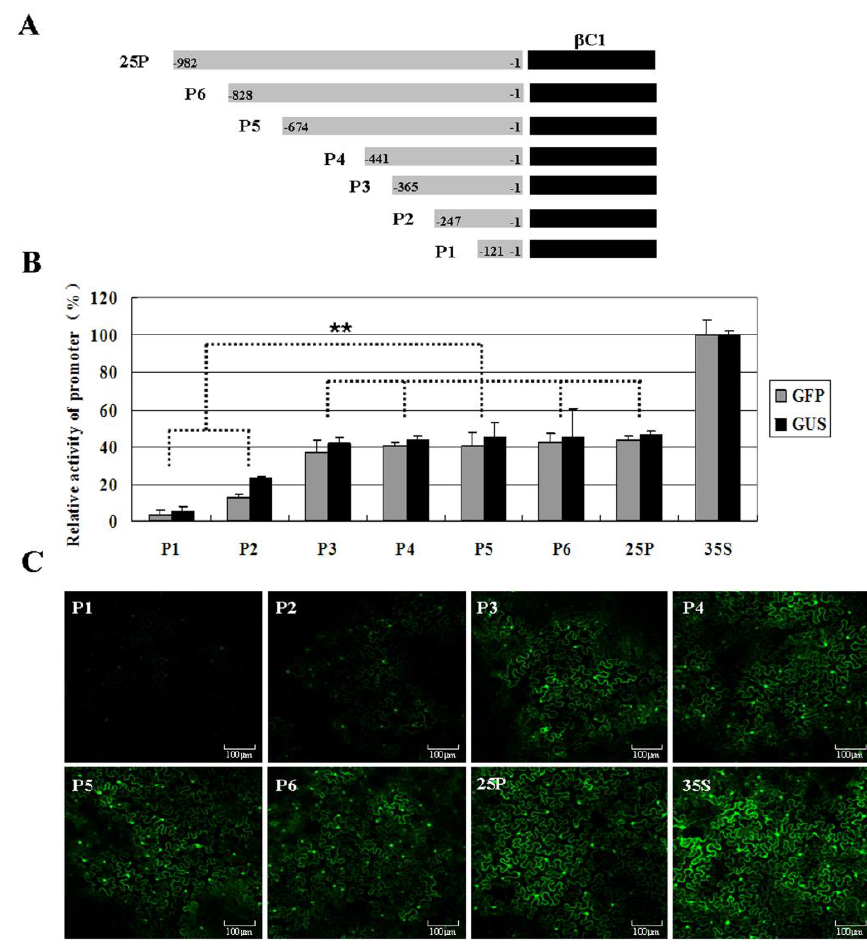
Figure 4. Identification of promoter activity in N . benthamiana leaves after transiently expressing various TYLCCNB-Y25 βC1 -derived promoters. ( A ) Schematic representation of the TYLCCNB-Y25 genome and various βC1 promoters fused to a promoter-less pINT121 or pCHF3:GFP vector; ( B ) fluorometric activity analysis after transient expression various promoter constructs. The mean GUS or GFP activity from the CaMV 35S promoter of pINT121 or pCHF3:GFP was considered as 100% and used to standardize the activities for all of the other constructs, respectively. Columns represent the mean value, with standard error of the mean. The significant difference between treatments (** p ≤ 0.01) was shown; ( C ) confocal microscopy showed GFP fluorescence after transient expression various promoter constructs.